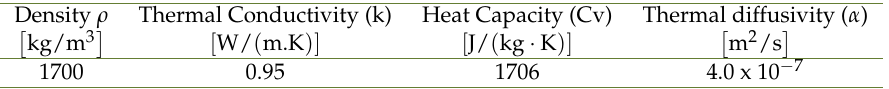
Table 1. Geothermal properties of considered soil